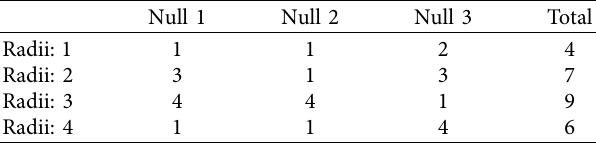
Table 18: Null depth performance ranking corresponding to null steering using cluster radii 1, 2, 3, and 4 (wavelength normalized).